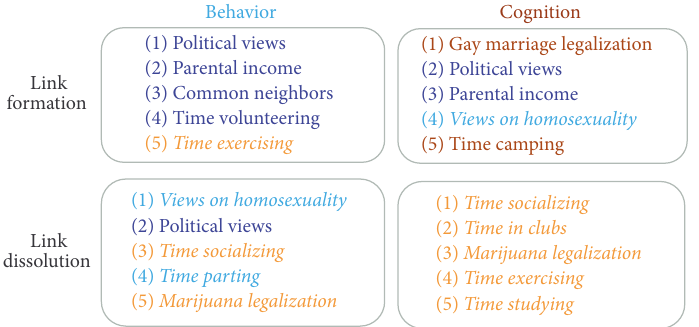
Figure 5: Comparison of top ranking attributes for link formation and dissolution of behavioral and cognitive edges. The four categories of edge dynamics, going from left to right and from top to bottom, are behavioral link formation, cognitive link formation, behavioral link dissolution, and cognitive link dissolution. The five highest ranking attributes for each category are shown in different colors. Interestingly, dissolution of cognitive edges has its attributes highest ranked among all categories. Only political views are shared by three categories, while parental income is common for link formation, and time socializing and marijuana legalization are common for link dissolution, while time exercising is shared diagonally and views on homosexuality are common along antidiagonal. Of the 13 distinct attributes listed, seven are unique for one category: common neighbors, time volunteering, gay marriage legalization, time camping, time parting, time in clubs, and time studying. More than half of listed attributes, seven, are some form of time spent together but, interestingly, different forms of spending time together have impact on different link categories of formation or